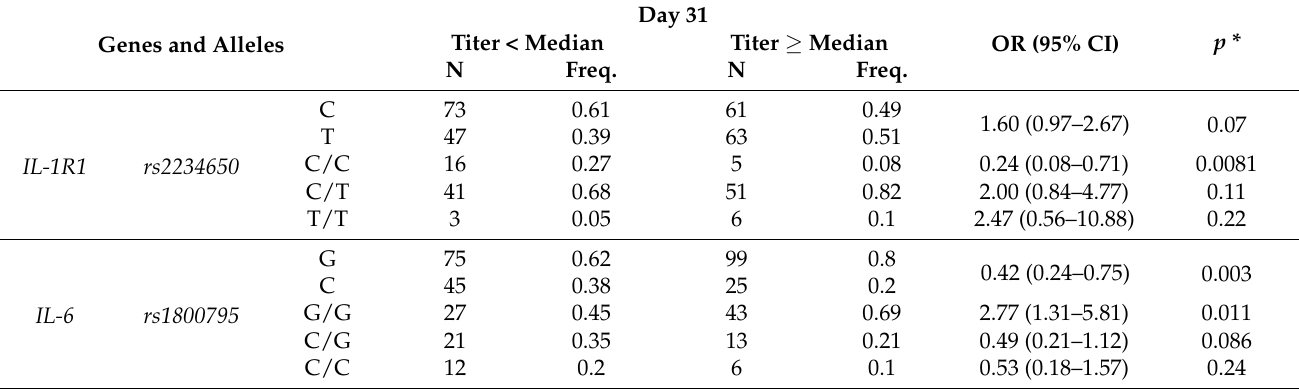
Table 6. Cytokine gene polymorphisms significantly affecting anti-SARS-CoV-2 S1/S2 antibody titers measured 31 days after administration of the second dose of anti-SARS-CoV-2 mRNA